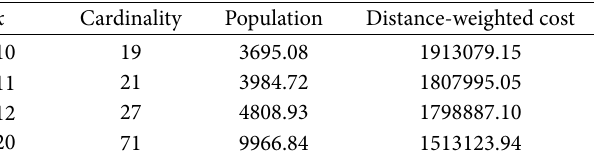
Table 3: Numerical results from the heuristic model for Fargo.